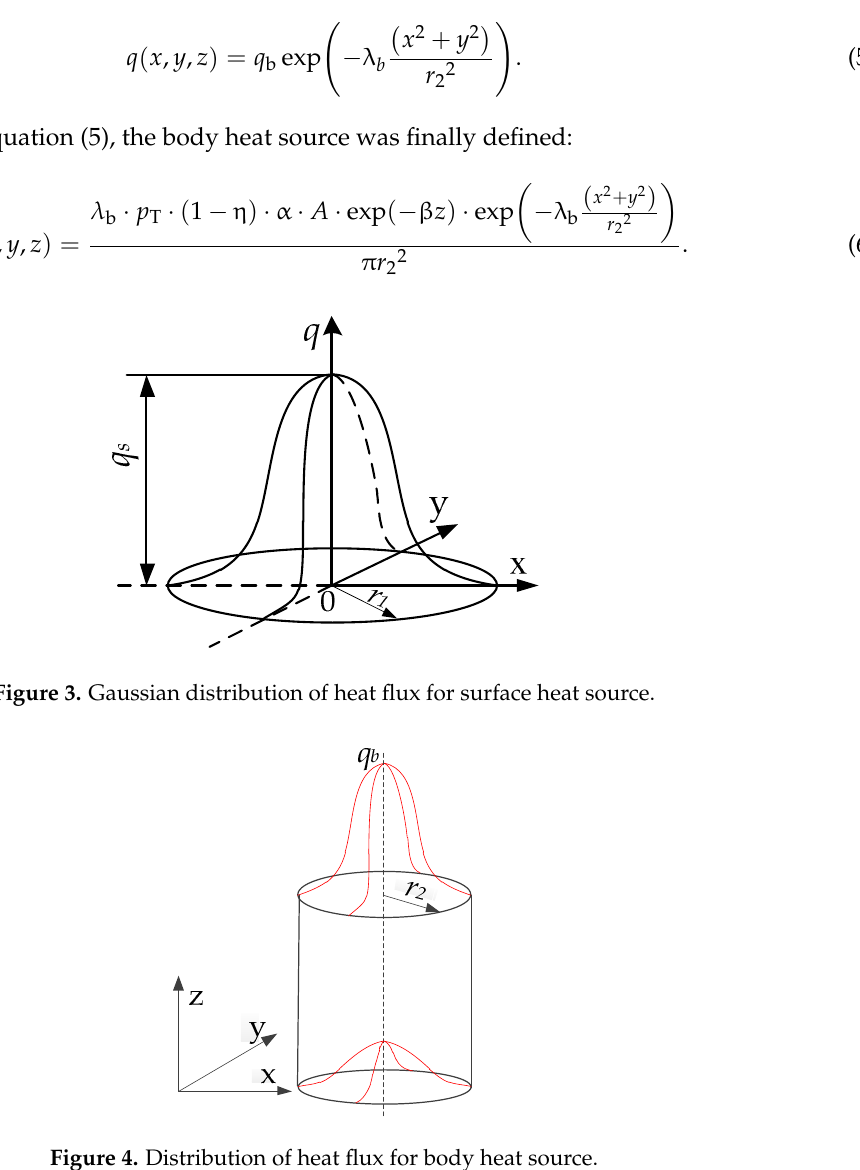
Figure 4. Distribution of heat flux for body heat source.